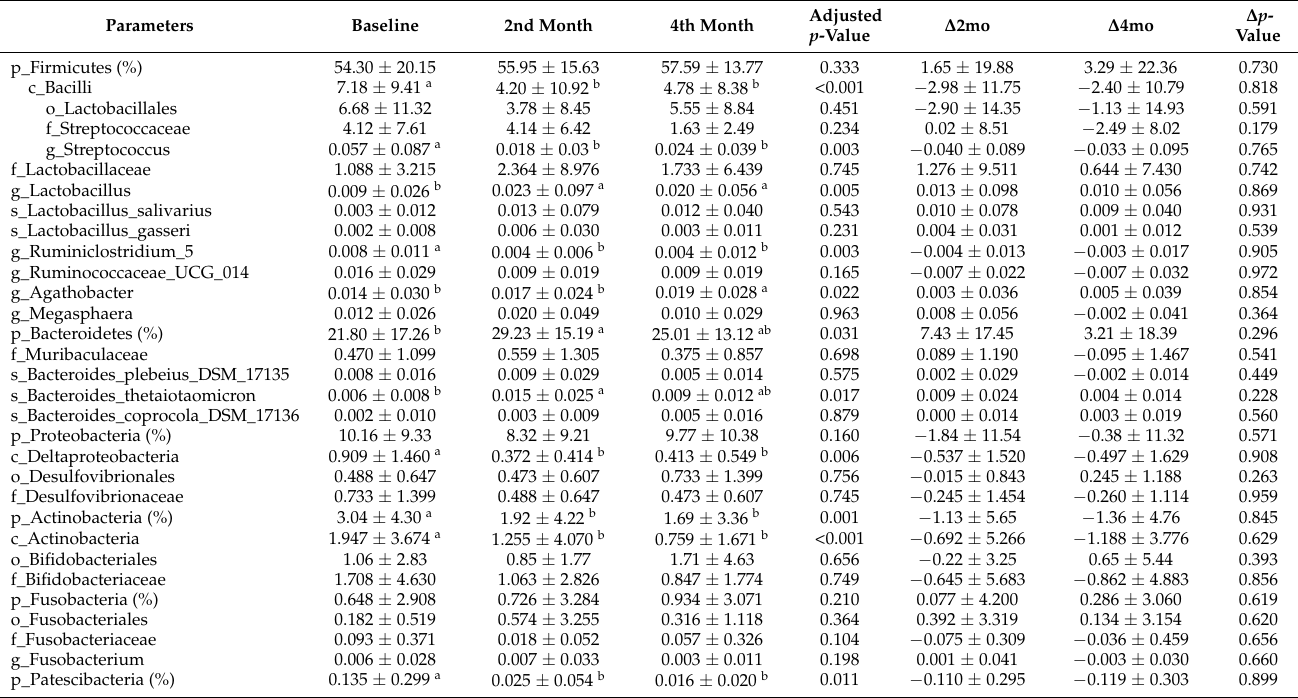
Table 6. The abundances of gut